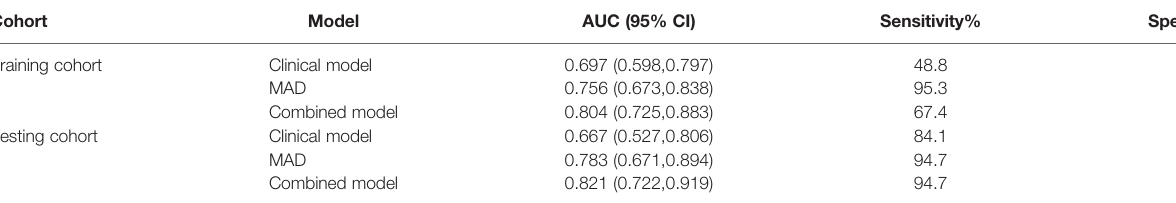
TABLE 5 | Performance of models in predicting early recurrence.